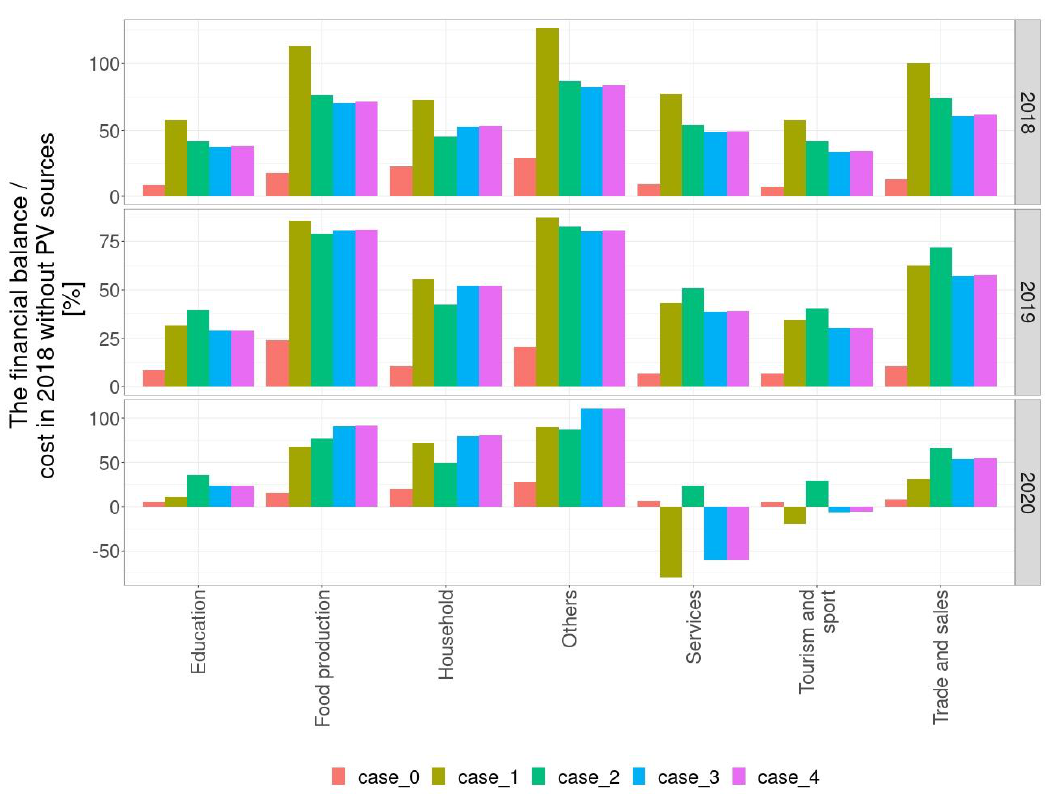
Figure 10. Share of the averaged balance of energy purchase costs for prosumers aggregated on the basis of economic activity for each year in the 2018–2020 period in relation to the energy purchase costs in 2018 prior to obtaining prosumer status.